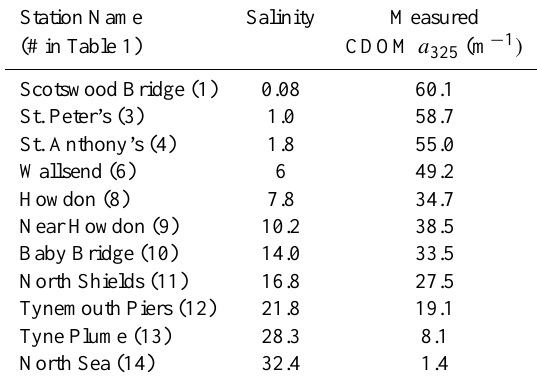
Fig. 5. Open ocean carbon monoxide apparent quantum yields (CO AQYs). Solid filled squares represent data calculated using pa- rameters listed in the Fig. 5 legend inset together with the open ocean CDOM absorbance coefficient at 412nm (absorbance data from Stubbins et al., 2006b). Other CO AQY spectra are for the Pa- cific Ocean (Zafiriou et al., 2003; long grey dash) and the Atlantic Ocean (Ziolkowski and Miller, 2007; solid grey line). Table 3. Measured salinity and coloured dissolved organic matter absorbance coefficient at 325nm (CDOM a 325 ) in the Tyne estuary on 9 April 2001. These values were used to calculate the conserva- tive mixing of CDOM and apparent quantum